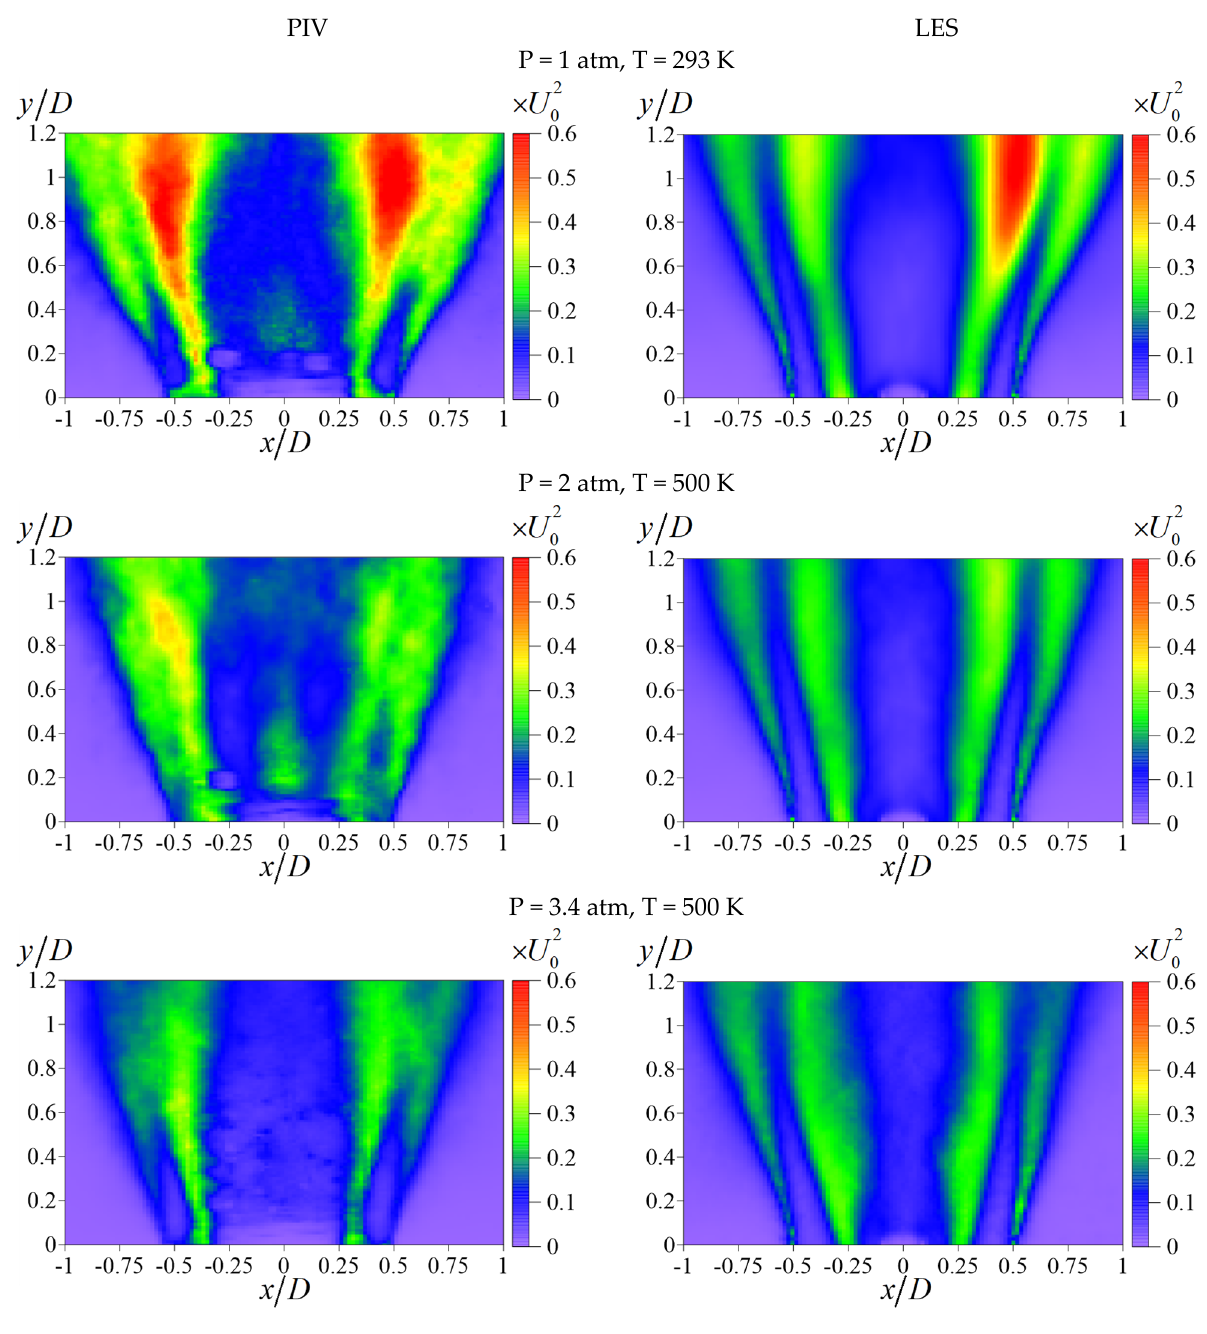
Figure 4. Standard deviation of the axial velocity fluctuations for PIV and LES.